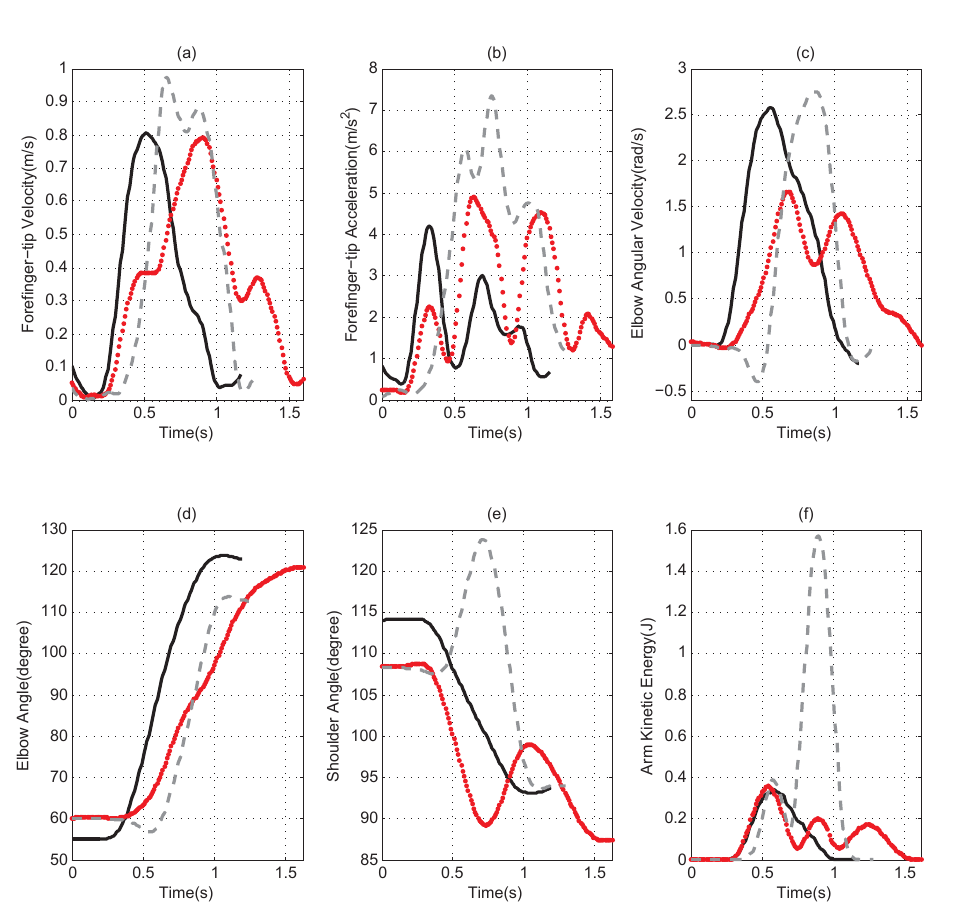
Figure 5: Kinematic and energy variations of three trajectories in Case A : (a) forefinger-tip velocity, (b) forefinger-tip acceleration, (c) elbow angular velocity, (d) elbow joint angle, (e) shoulder joint an- gle, (f) arm kinetic